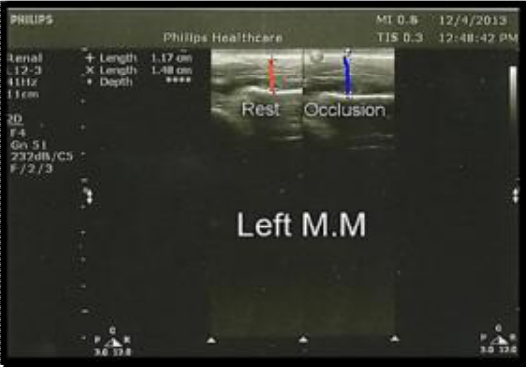
Figure 5: Left Masseter Muscle Thickness Scanning, the Red Arrow Representing Masseter Muscle Thickness (mm) under Rest Condition, and the Blue Arrow Representing Masseter Muscle Thickness (mm) under Occlusion